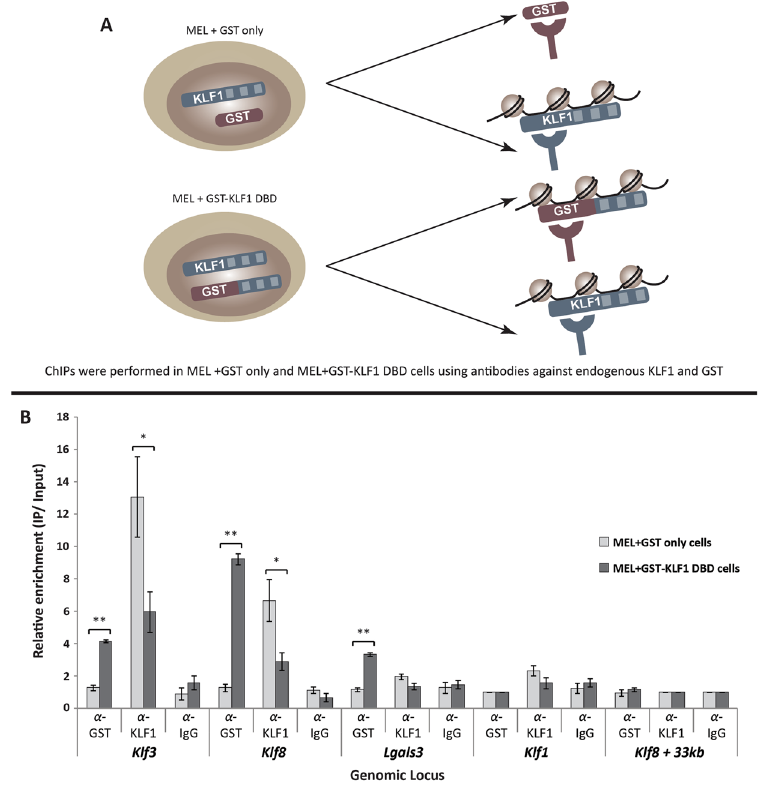
Figure 4. The GST-KLF1 DBD protein displaces endogenous KLF1 at a number of KLF1 target genes in vivo . ( A ) Schematic depicting the experimental design of the ChIP experiment. ( B ) ChIPs were performed using α -KLF1, α -GST and α -IgG in both in MEL + GST and MEL + GST-KLF1 DBD clones, (n = 4 for each group per IP). Data are represented as the fold-change enrichment of IP over input, where the negative control for each IP, the Klf1 promoter for GST, and the Klf8 + 33 kb locus for both KLF1 and IgG, was set to 1. The Klf3 1b and Klf8 promoters have been included as positive controls while the Klf1 promoter, and Klf3 + 10 kb and Klf8 + 33 kb genomic regions are shown as negative controls. Error bars shown represent standard error of the mean, p values indicate the difference between the means, * p < 0.05, ** p < 0.01 (paired Student’s two-tailed t